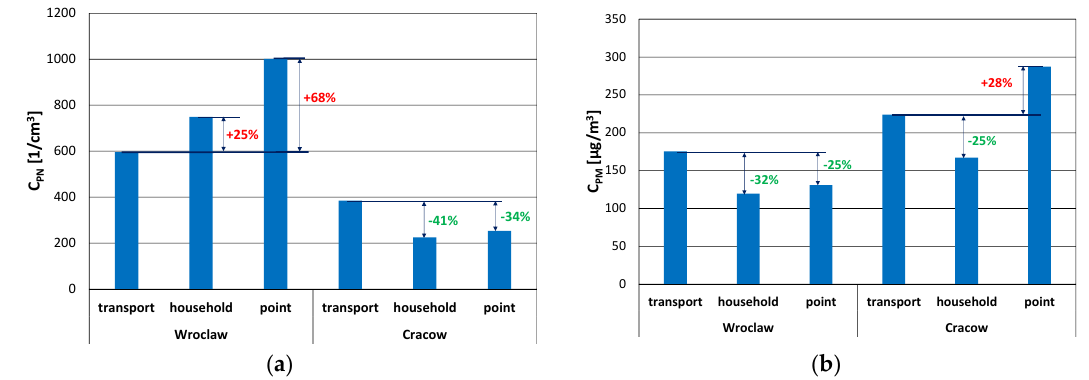
Figure 6. Total average concentration of particles distribution in terms of: ( a ) number, ( b ) mass.